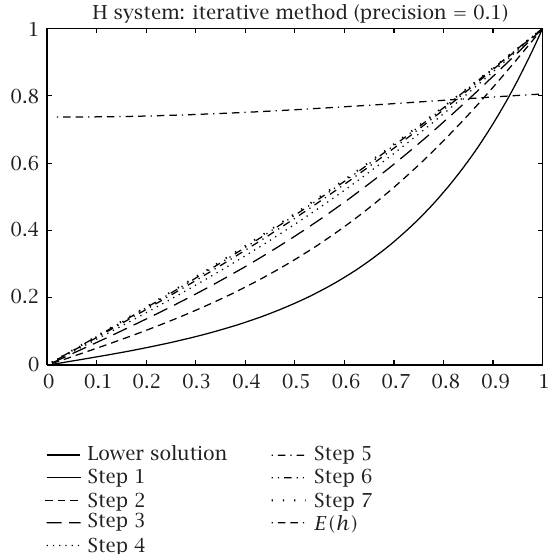
Figure 3.1. H system: iterative method (precision = 0 .